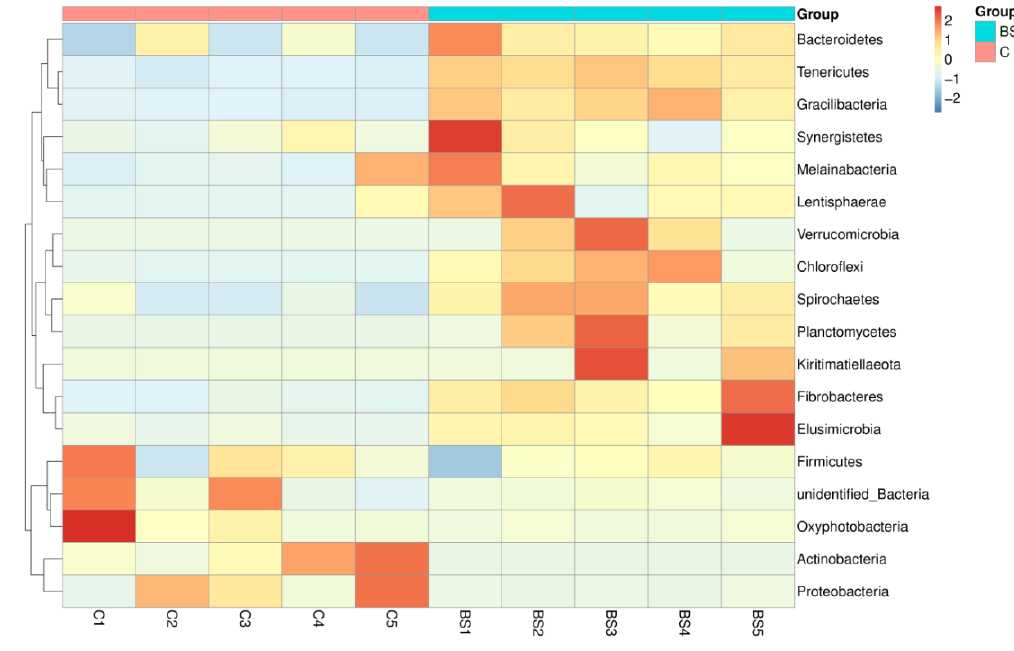
Figure 3. Analysis of rumen bacterial populations at the phylum classification level.